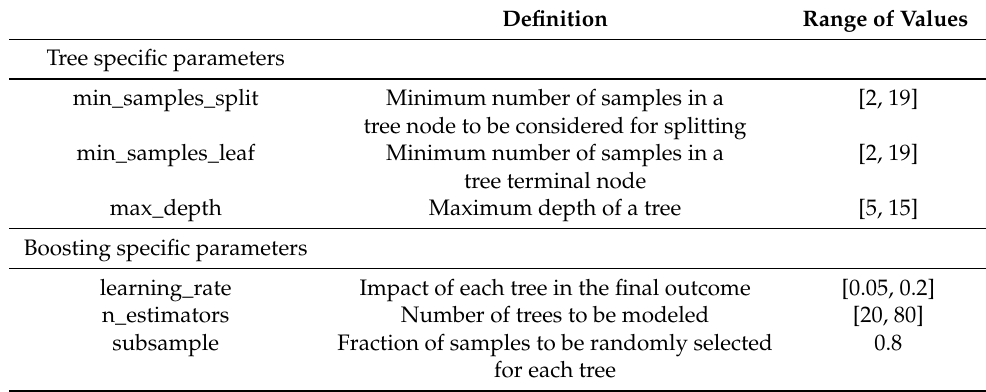
Table 2. Tree and boosting specific parameters of the gradient boosting regression algorithm as they appear in the scikit-learn package together with their definition. The last column shows the range of values that were tested in the algorithm optimization